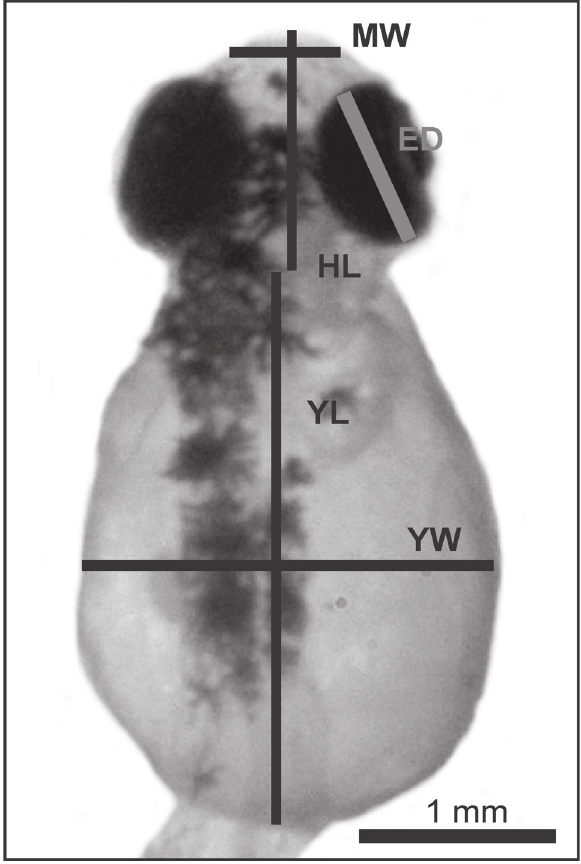
Fig. 2. Dorsal view of newly hatched free embryo.